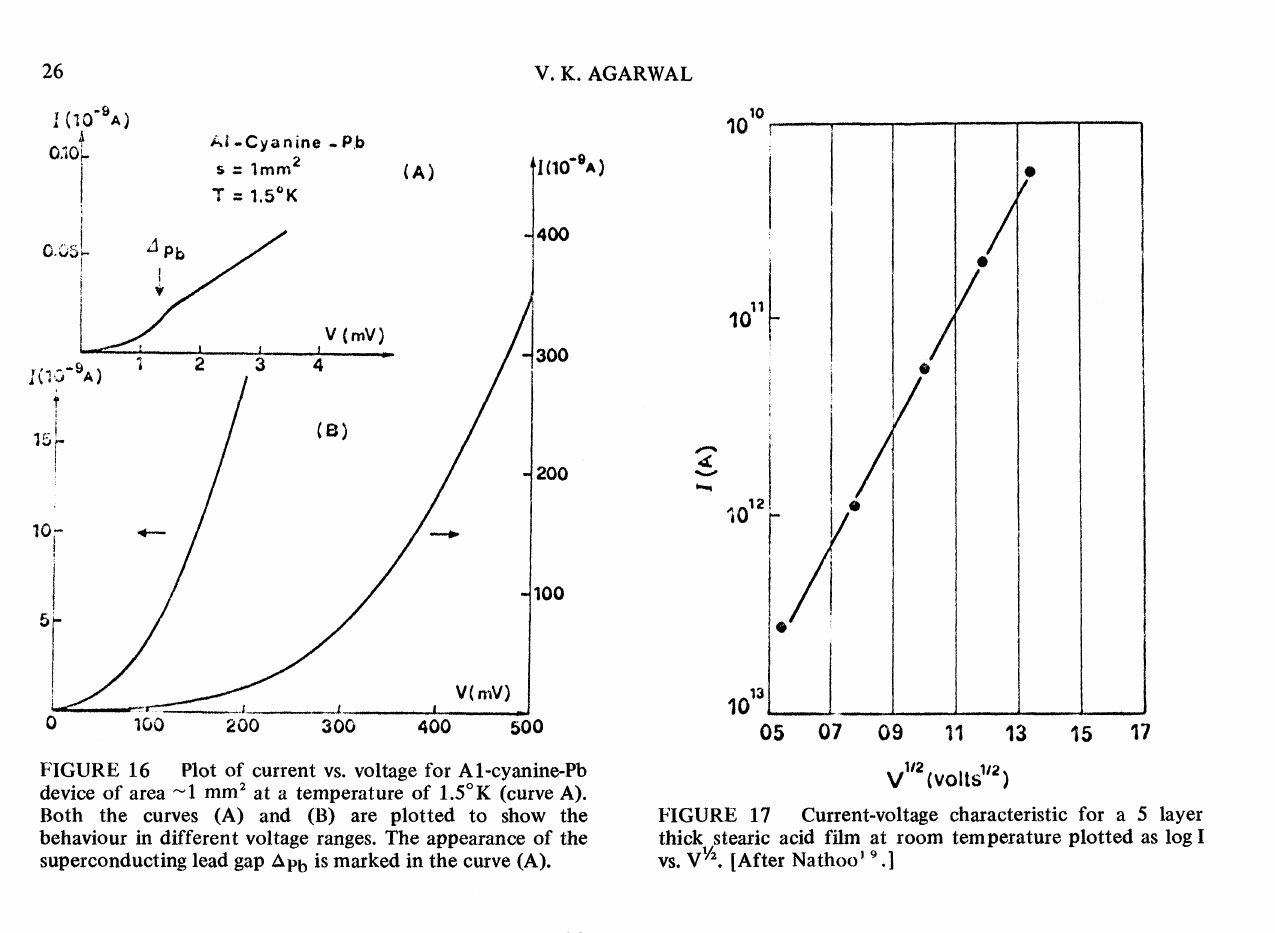
FIGURE 16 Plot of current vs. voltage for A l-cyanine-Pb device of area --1 mm at a temperature of 1.5K (curve A). Both the curves (A) and (B) are plotted to show the behaviour in different voltage ranges. The appearance of the superconducting lead gap Apb is marked in the curve (A).